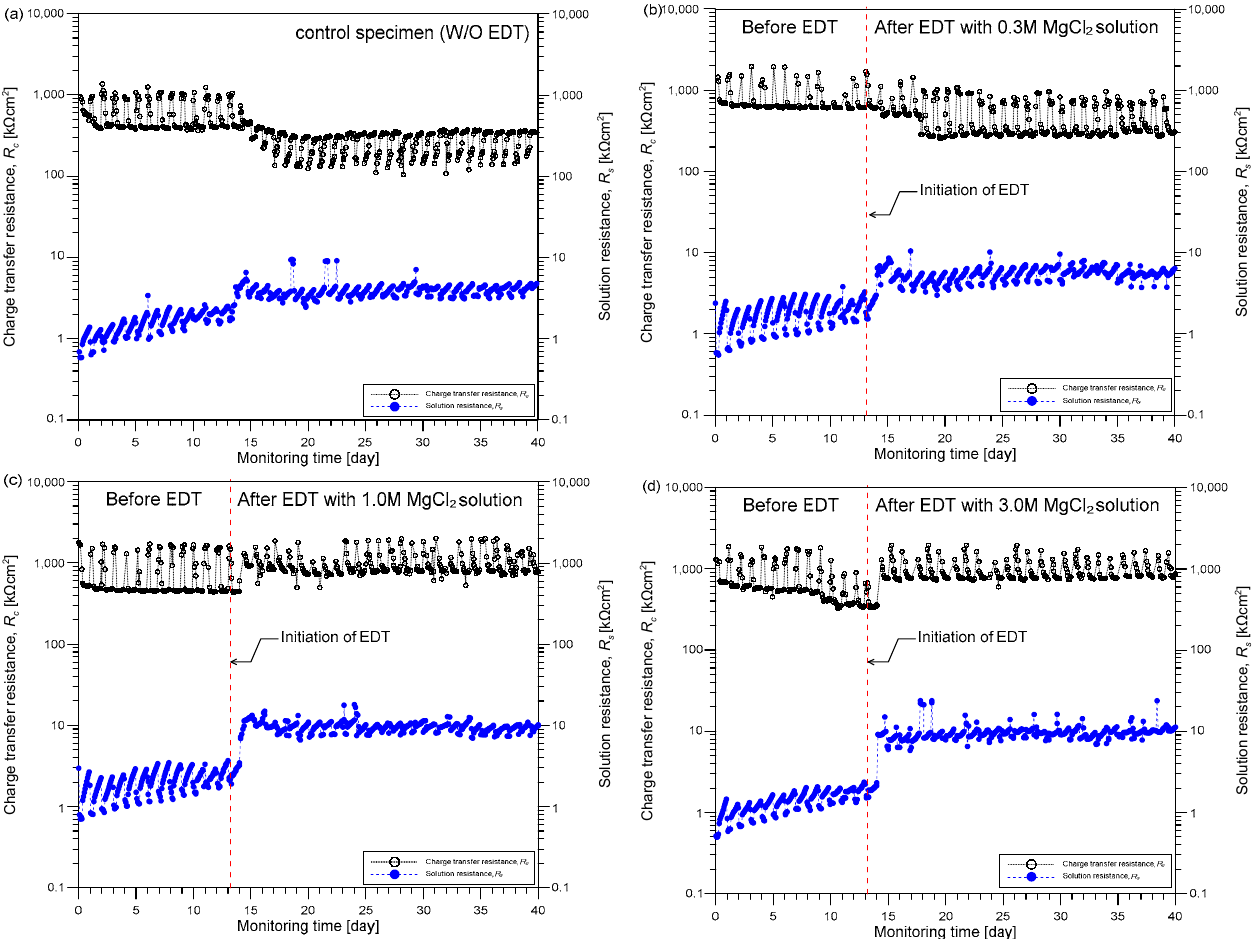
Figure 8. The variation of charge transfer resistance R c and the solution resistance R s in the four concrete prism samples in test phase 1: ( a ) the control sample without EDT, TP1-1, ( b – d ) the three rehabilitated samples treated by EDT with three different concentration levels of MgCl 2 solution: ( b ) 0.3M, ( c ) 1M and ( d ) 3M, respectively.